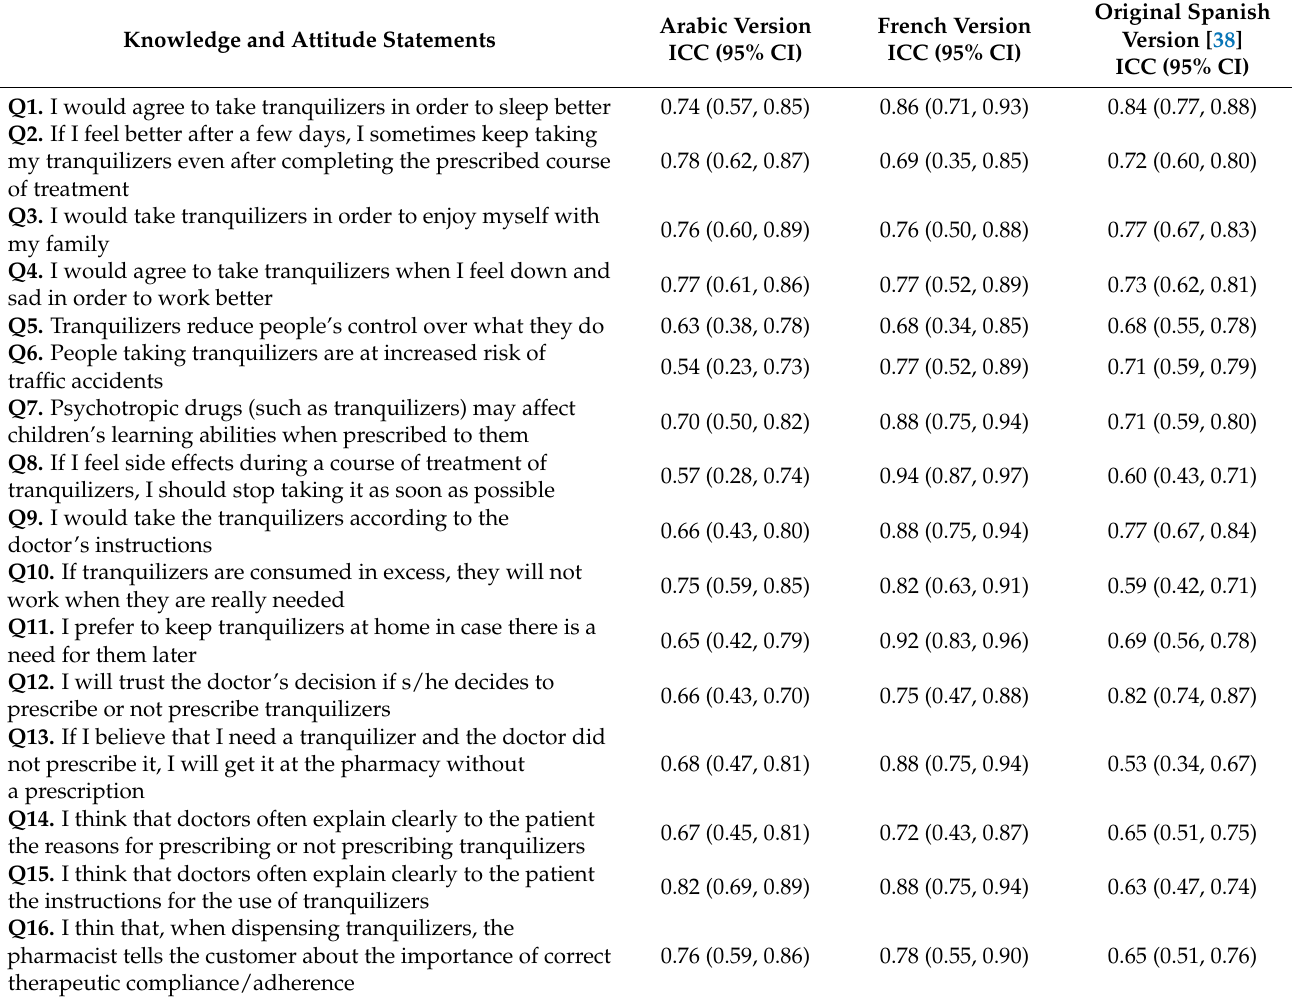
Table 1. Test–retest reliability assessment of Knowledge and Attitudes items of the KAP questionnaire on tranquilizer use.